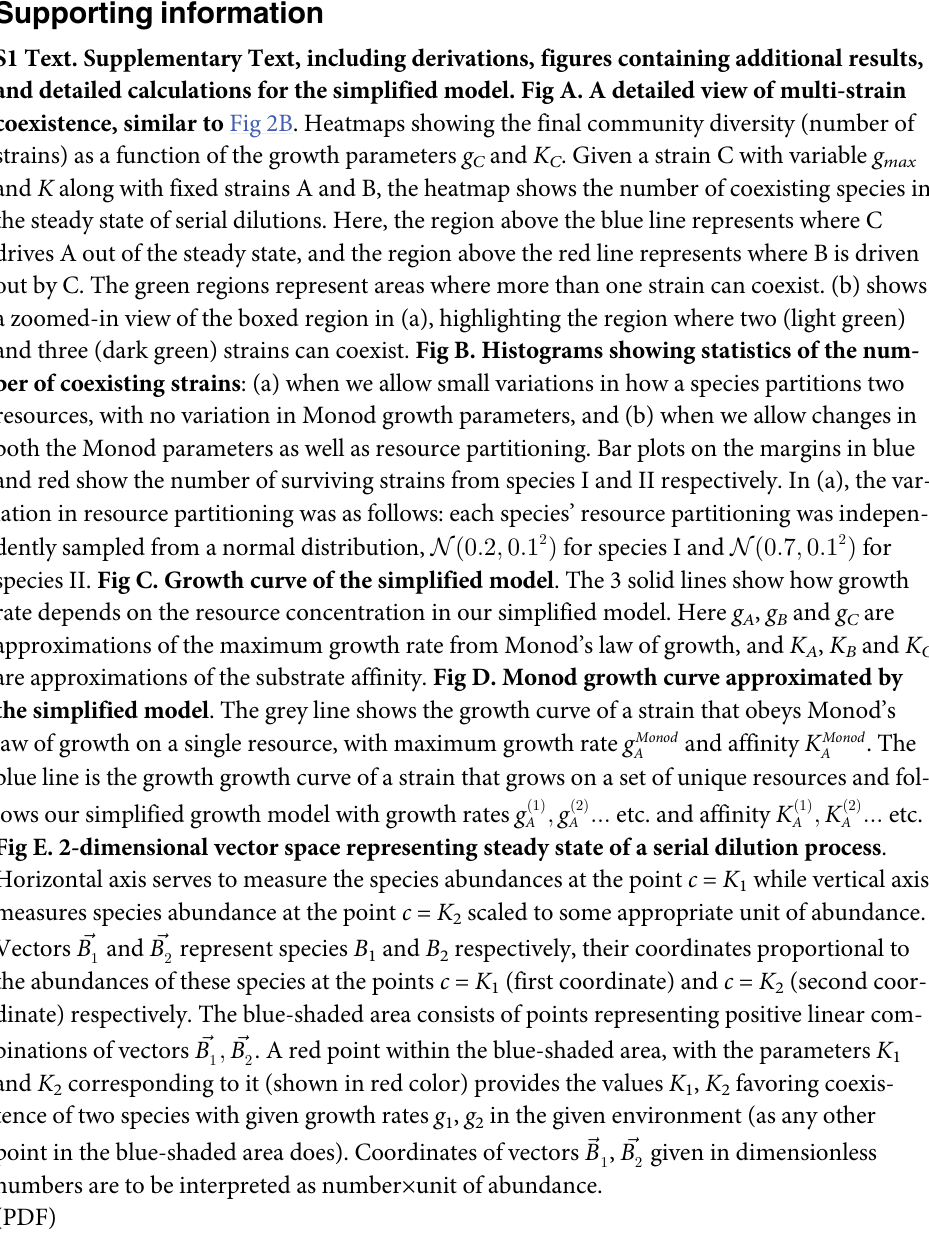
Fig E. 2-dimensional vector space representing steady state of a serial dilution process . Horizontal axis serves to measure the species abundances at the point c = K while vertical axis 1 measures species abundance at the point c = K scaled to some appropriate unit of abundance. 2 Vectors ~ B and ~ B represent species B and B respectively, their coordinates proportional to 1 2 1 2 the abundances of these species at the points c = K (first coordinate) and c = K (second coor- 1 2 dinate) respectively. The blue-shaded area consists of points representing positive linear com- binations of vectors ~ B ; ~ B . A red point within the blue-shaded area, with the parameters K 1 1 2 and K corresponding to it (shown in red color) provides the values K , K favoring coexis- 2 1 2 tence of two species with given growth rates g , g in the given environment (as any other 1 2 point in the blue-shaded area does). Coordinates of vectors ~ B , ~ B given in dimensionless 1 2 numbers are to be interpreted as number × unit of